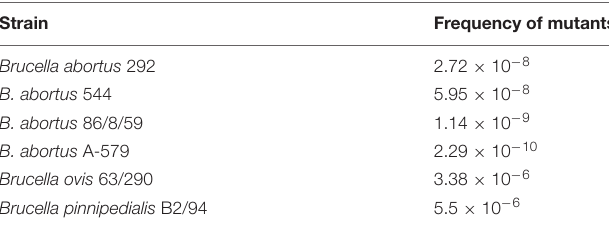
TABLE 3 | Observed frequency of appearance of CO 2 -independent mutants in different Brucella